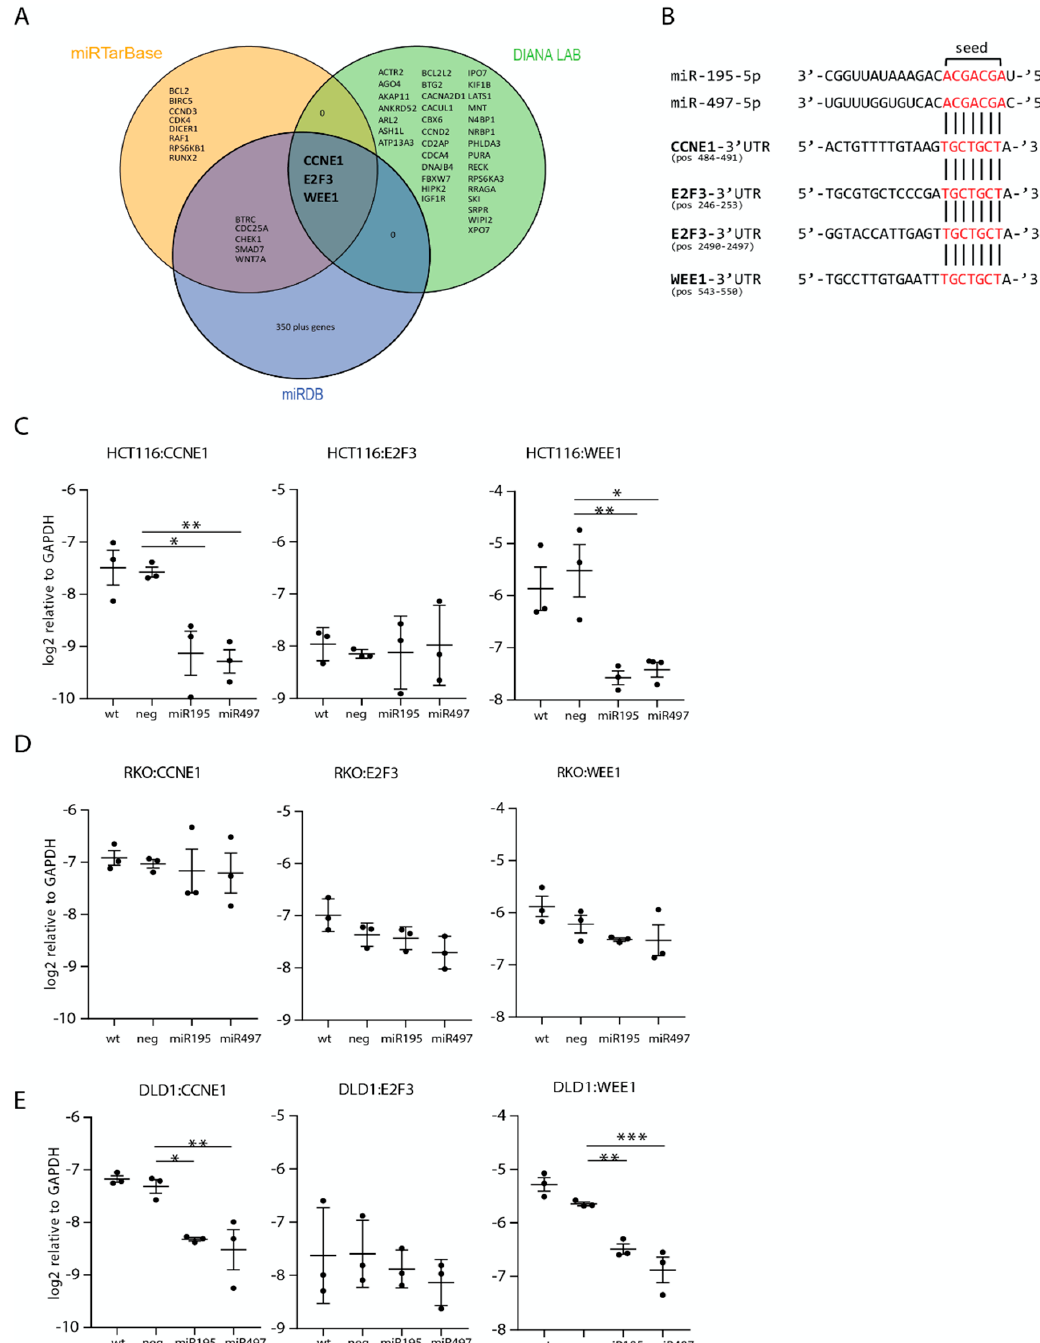
Figure 3. miR-195-5p and miR-497-5p target selection and quantification. ( A ) Venn diagram of the targets selected with miRTarBase, DIANA LAB, and miRDB with the coinciding target mRNAs of the three databases presented in the center. ( B ) Mature miRNA sequence of miR-195-5p and miR-497-5p matched to the 3 ′ UTR target region of the selected targets with the seed sequence of each miRNA shown in red. Expression levels, presented as log 2 relative to GAPDH of the specific mRNA targets CCNE1, E2F3, and WEE1, measured with RT-qPCR in HCT116 cells ( C ), RKO cells ( D ) and DLD-1 cells ( E ). Each target for each transfection is quantified in duplicate in three independent experiments, presented as average ± the SEM. wt: wild-type non-transfected control, neg: negative control transfection (cel-miR-39-3p). * p < 0.05, ** p < 0.01, *** p < 0.001.